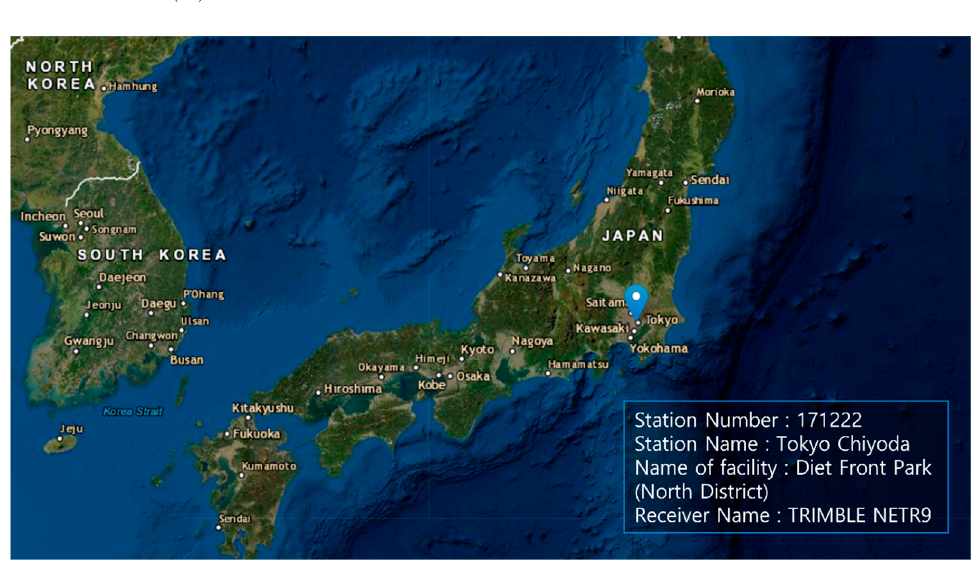
Figure 2. GNSS data obtained from a GEONET base station located at Chome-1 Nagatacho, Chiyoda